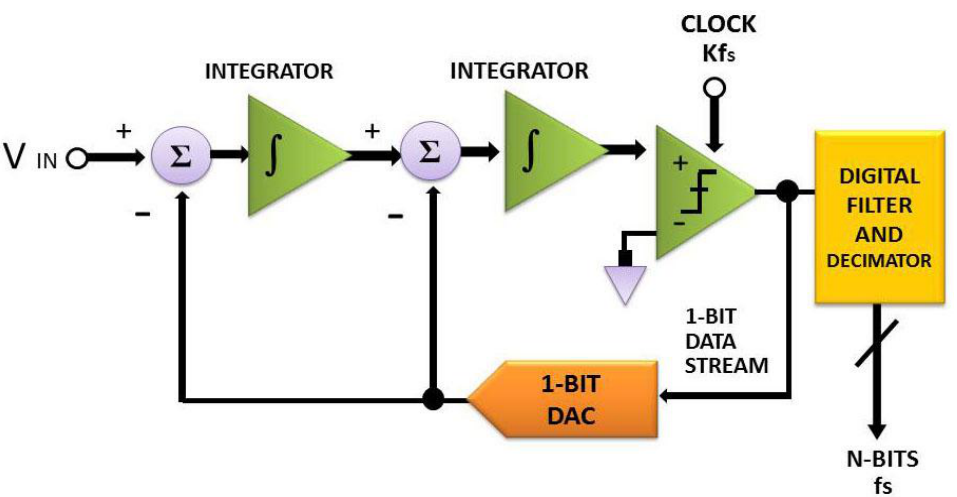
Figure 5. The schematic block diagram of a second order Σ-Δ AD converter with fs representing the sampling